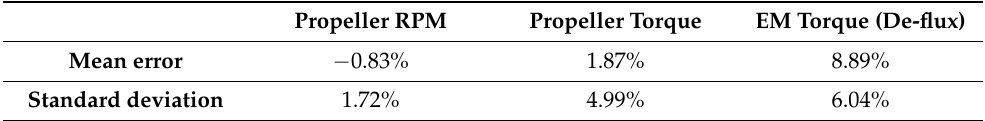
Table 6. Test 2 simulation error and error standard